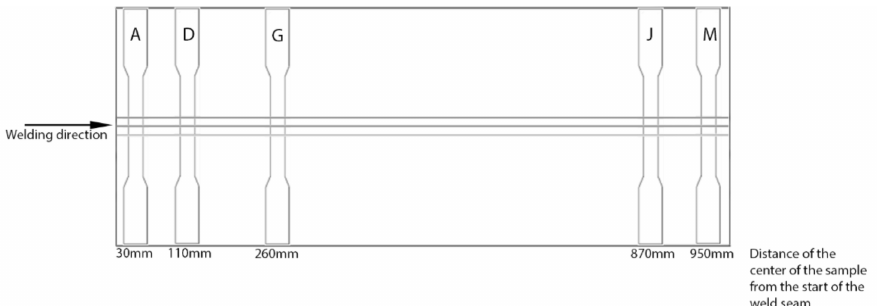
Figure 3. Locations of the specimens for tensile tests testing the difference in strength along the weld axis.